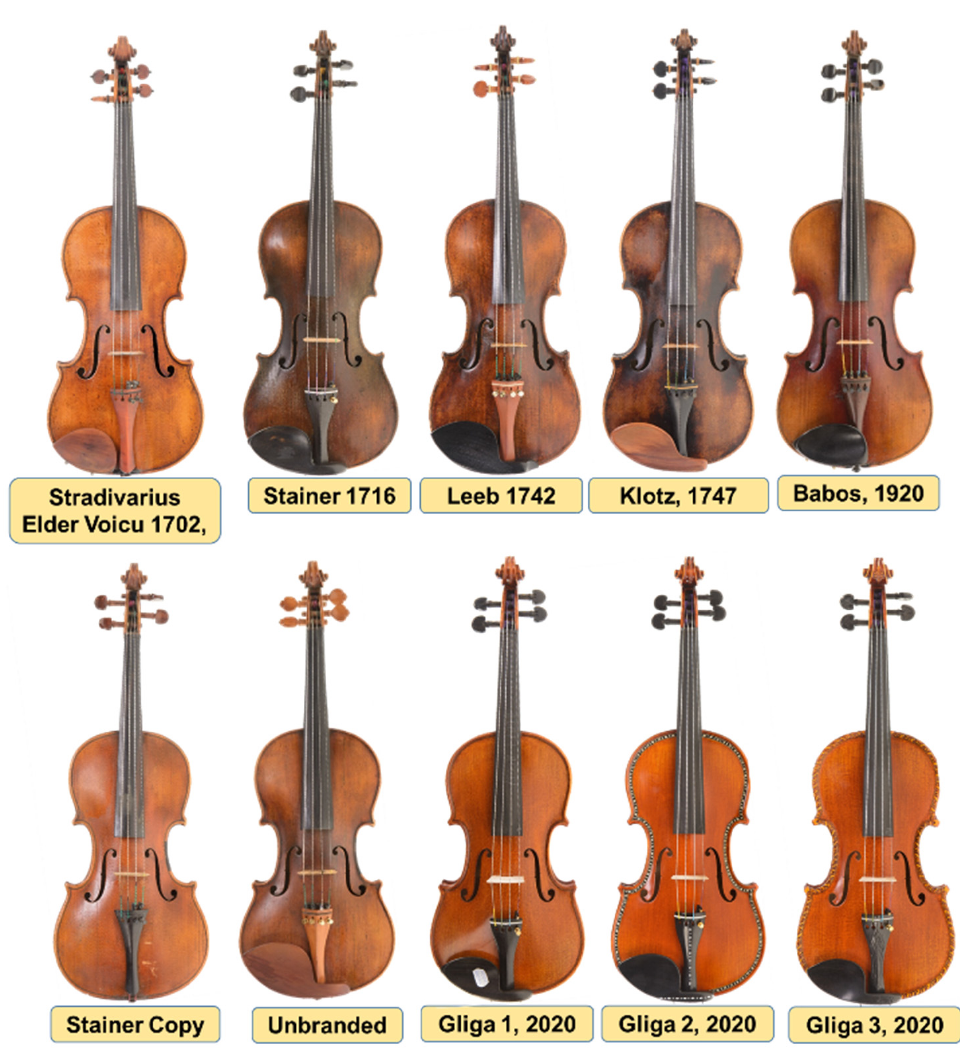
Figure 2. The studied